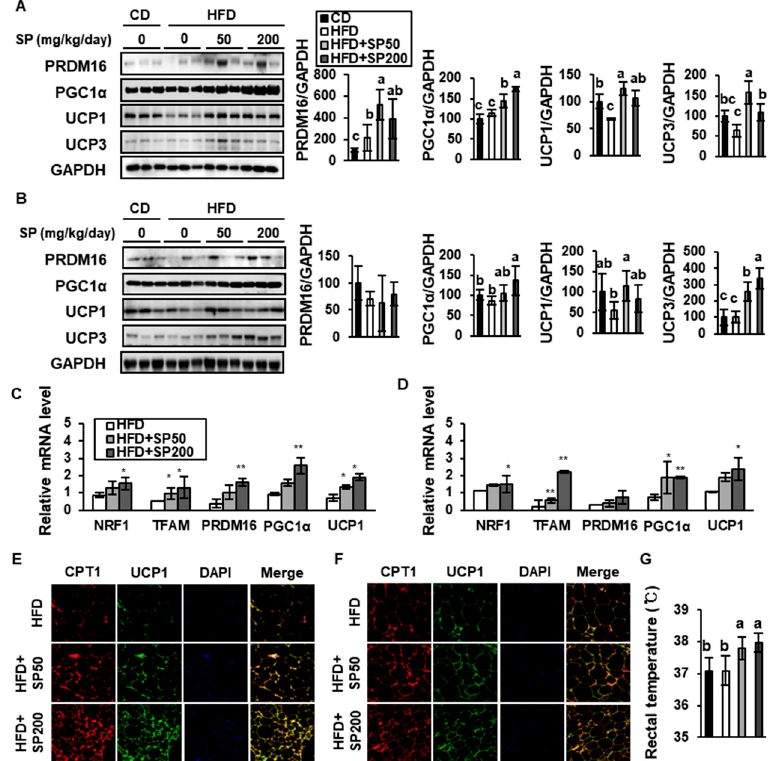
Figure 7. The e ff ect of silk peptide on the browning of white adipose tissue in HFD-induced obese mice. The expression of browning markers (PRDM16, PGC1 α , UCP1, and UCP3) in ( A ) sWAT and ( B ) vWAT was determined by western blotting. The expression of thermogenesis-related genes in ( C ) sWAT and ( D ) vWAT was measured using qRT-PCR. * p < 0.05 and ** p < 0.01 indicates significantly di ff erence from HFD group. The immunofluorescence images of ( E ) sWAT and ( F ) vWAT were captured at 800 × magnification. ( G ) Rectal body temperature after 6 weeks of treatment ( n = 10), measured during the daytime at an ambient temperature of 22 ◦ C. Data are expressed as mean ± SD ( n = 8). Values with di ff erent letters were significantly di ff erent; p < 0.05 (a > ab > b > bc >